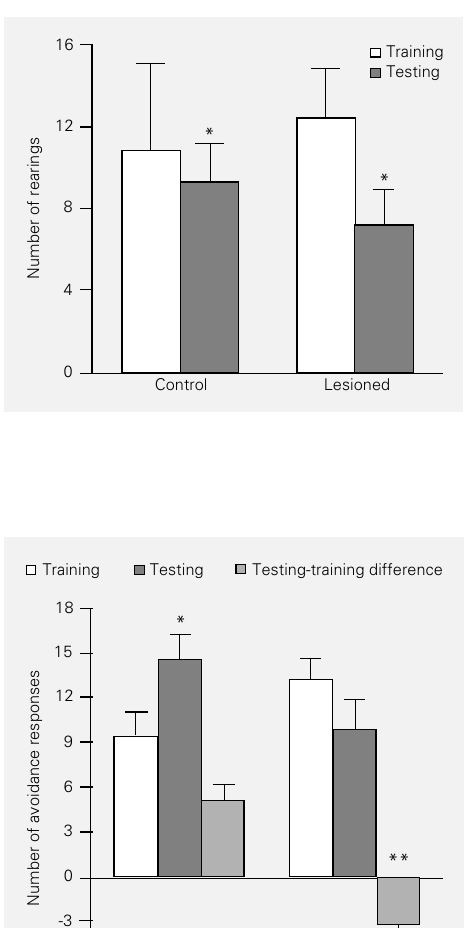
Figure 3 - Effect of a pretraining lesion of the entorhinal cortex on performance in a step-down inhibitory avoidance task. Data are reported as median (inter- quartile range) (N = 8 animals/ group). There were no signifi- cant differences between groups (P>0.05, Mann-Whitney U-test).